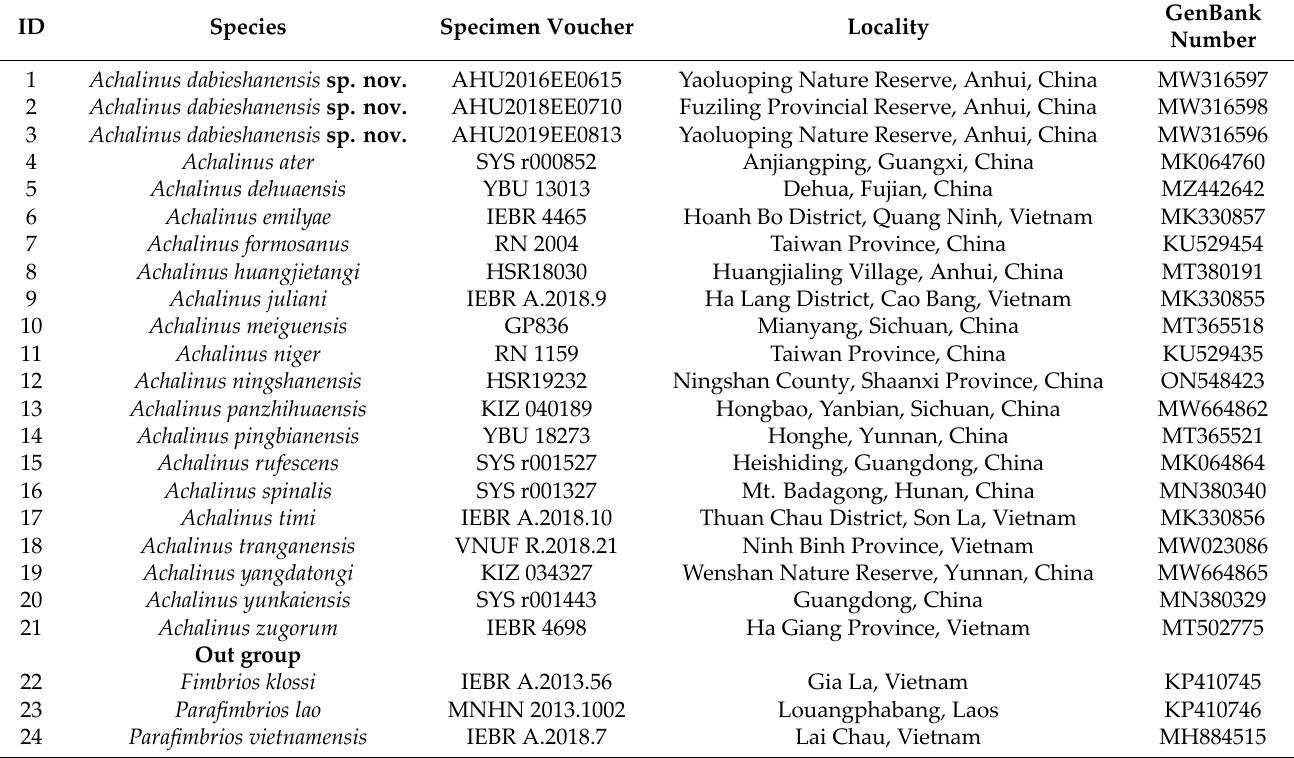
Table 1. Samples used for molecular phylogenetic analysis in this